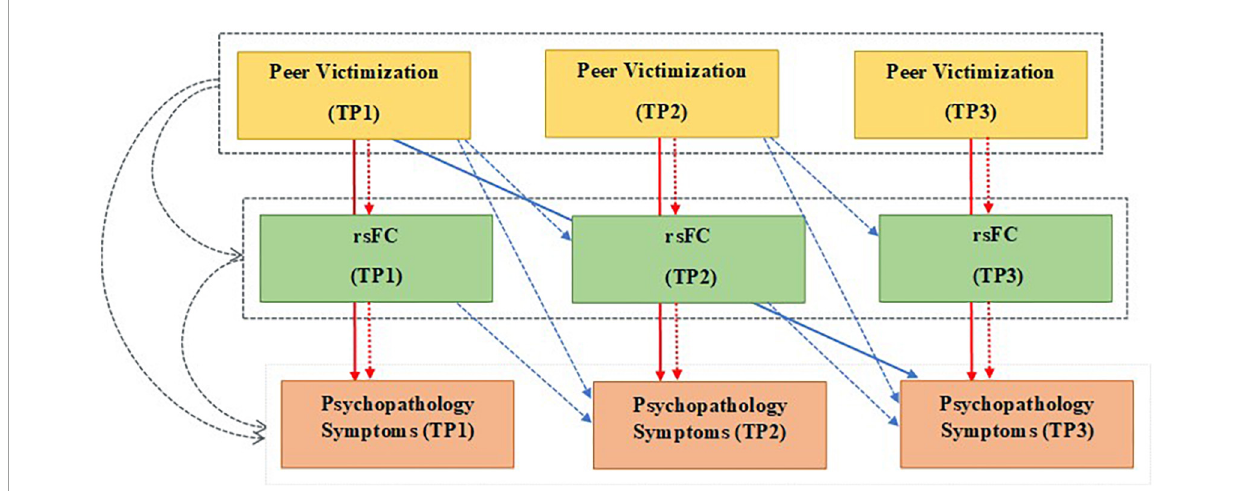
FIGURE1 Multilevel mediation model testing the indirect effects of peer victimization on psychopathology symptoms through the resting-state functional connectivity (rsFC) using longitudinal data from three waves of the study (TP1-3). Colored arrows show three time-varying aspects of each variable: Gray: Between-person effect. Red: Within-person effect, and Blue: Lagged-within -person effect. Solid arrows: Direct effects of peer victimization on psychopathological symptoms, dashed arrows: Indirect effects of peer victimization on psychopathological symptoms through rsFC (mediators). Gray dashed boxes around peer victimization and rsFC: Average levels of each variable over three time points. TP, time point; rsFC, resting-state functional connectivity; psychopathology symptoms: internalizing and externalizing symptoms.